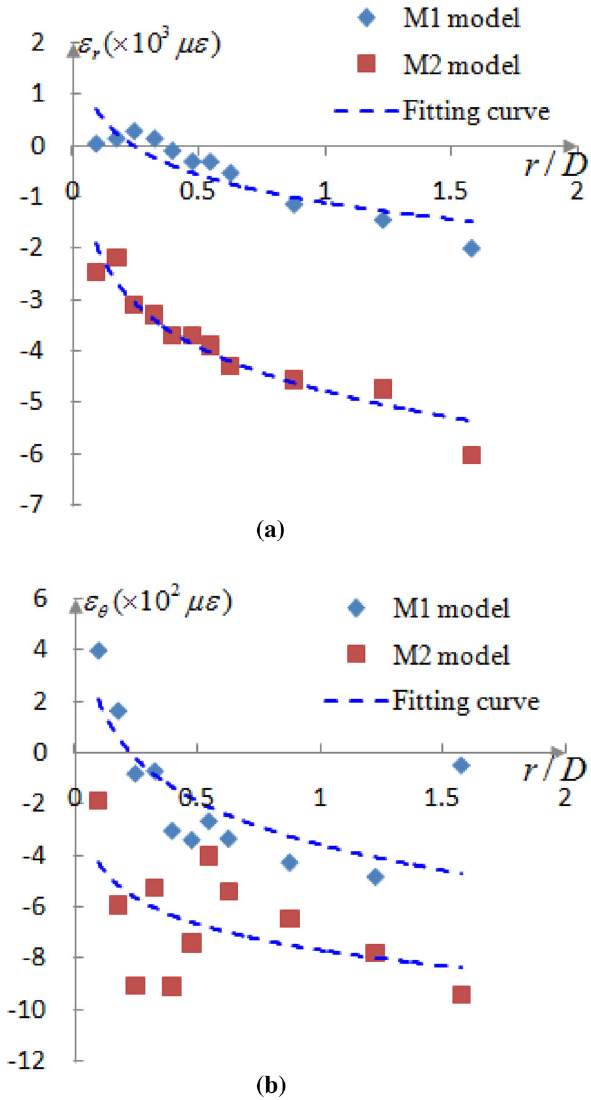
Fig. 16 a Radial and b circumferential strain curves at the bottom part of the tunnels in the M1 and M2 models under the maximum